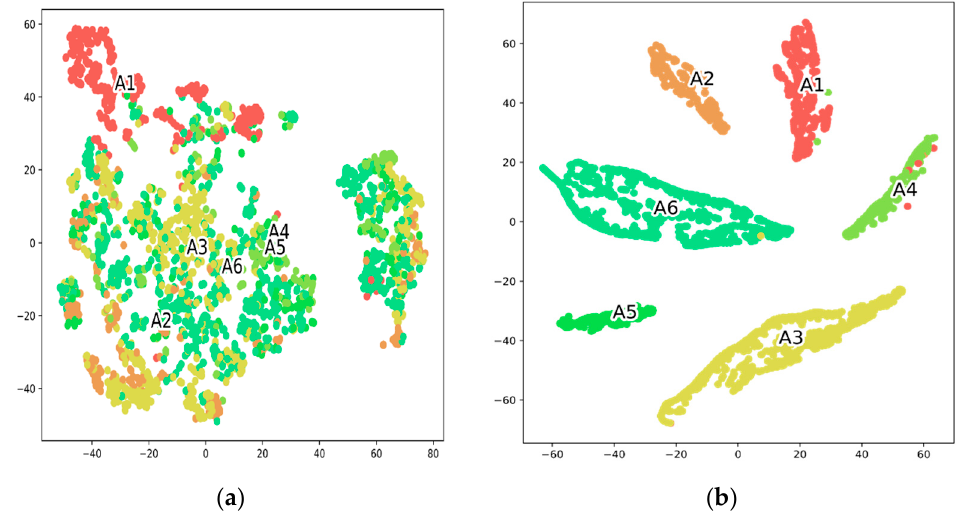
Figure 10. Two-dimensional T-SNE visualization of the testing data before ( a ) and after ( b ) learning representations of the proposed STC-NLSTMNet model.